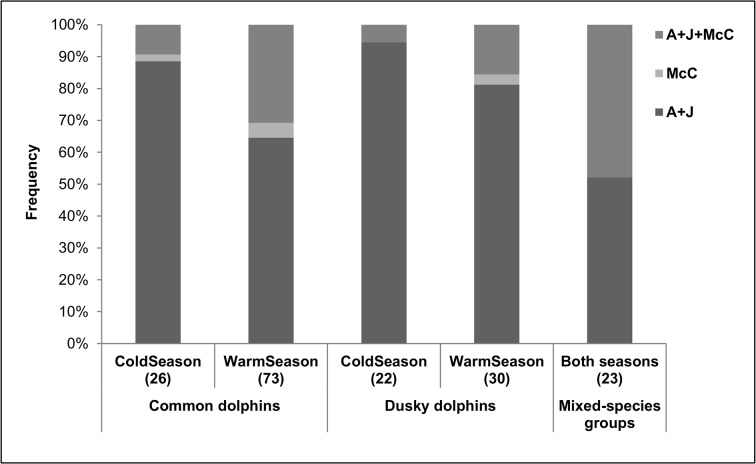
Social composition of groups.Percentages of occurrence of social categories for common dolphins (Delphinus delphis), dusky dolphins (Lagenorhynchus obscurus) and mixed-species groups recorded in each season. (A+J) adults and juveniles, (MwC) mothers with calves, (A+J+MwC) mixed combination of mothers with calves, juveniles and adults. The number in parentheses indicates the sample size.